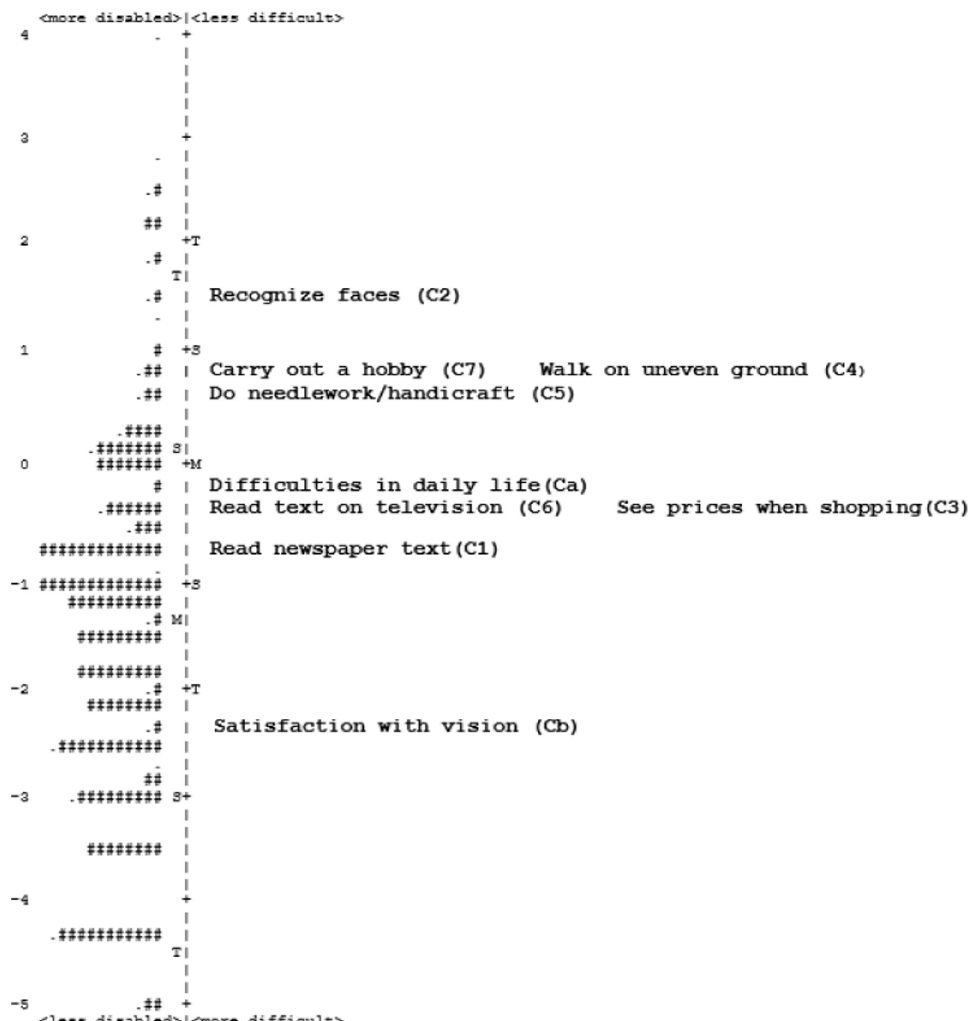
Fig 2. Person-item map for Catquest-9SF. Respondents are shown on the left side of the dashed line and items are shown on the right side. Respondents who are less disabled (have higher visual function) and items that are more difficult (respondents are more likely to rate having greater difficulties with tasks) are located at the bottom. Each ‘#’ represents 2 respondents and each ‘.’ represents 1 respondent. M = mean, S = 1 standard deviation, T = 2 standard deviations. The scale is in